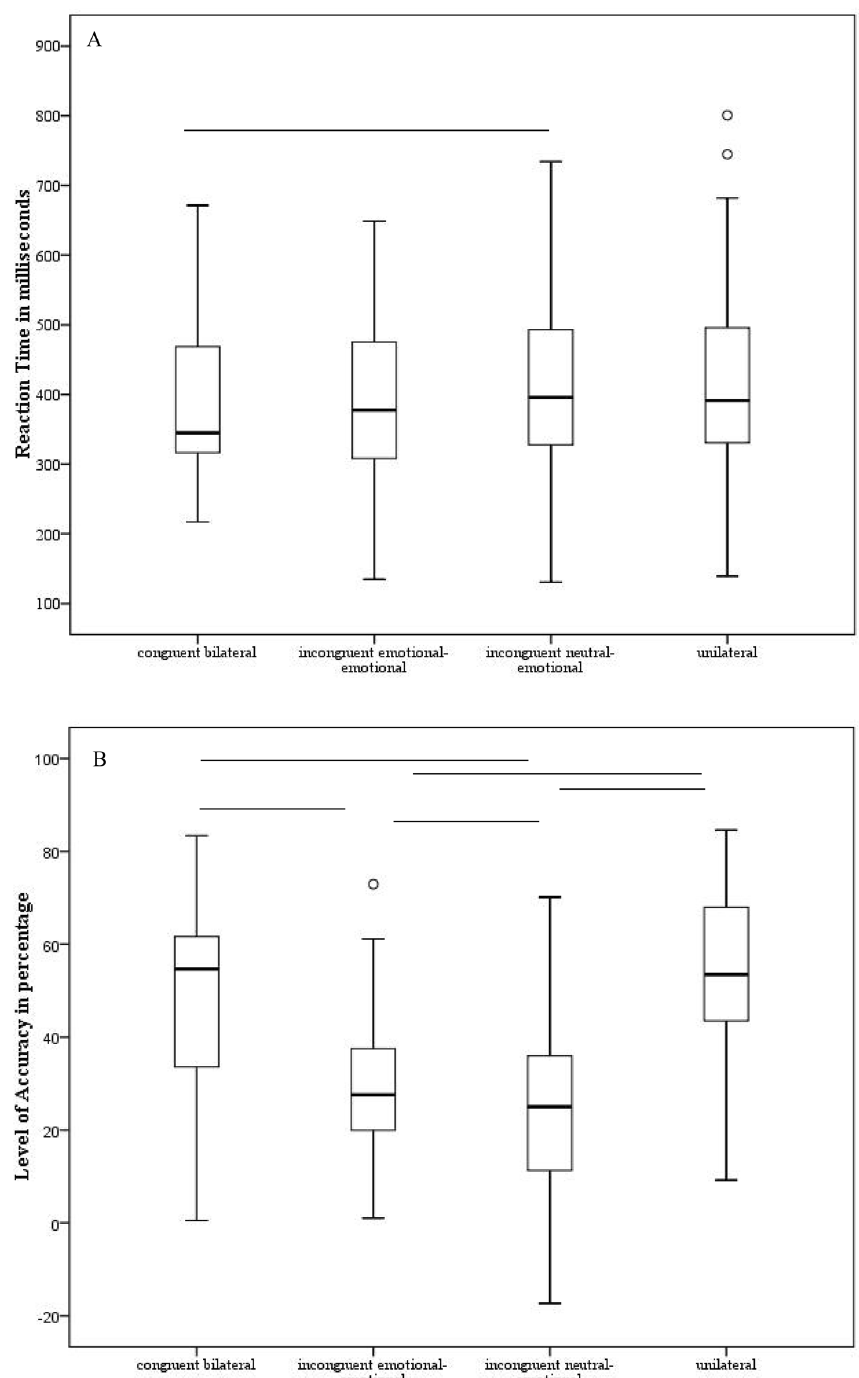
Figure 4. For each experimental condition (congruent bilateral, incongruent emotional-emotional, incongruent neutral-emotional congruent, unilateral; x-axis), the mean relative to the reaction time expressed in milliseconds ( A ) on the y-axis (left panels) and the level of accuracy expressed in percentage ( B ) on the y-axis (right panels) are depicted, when the emotion of anger was tested. The upper part regards the emotion of fear; the lower part, the emotion of anger. The minimum, the lower quartile, the median, the upper quartile, the maximum, and the outliers are shown. Horizontal lines denote significant differences at p <